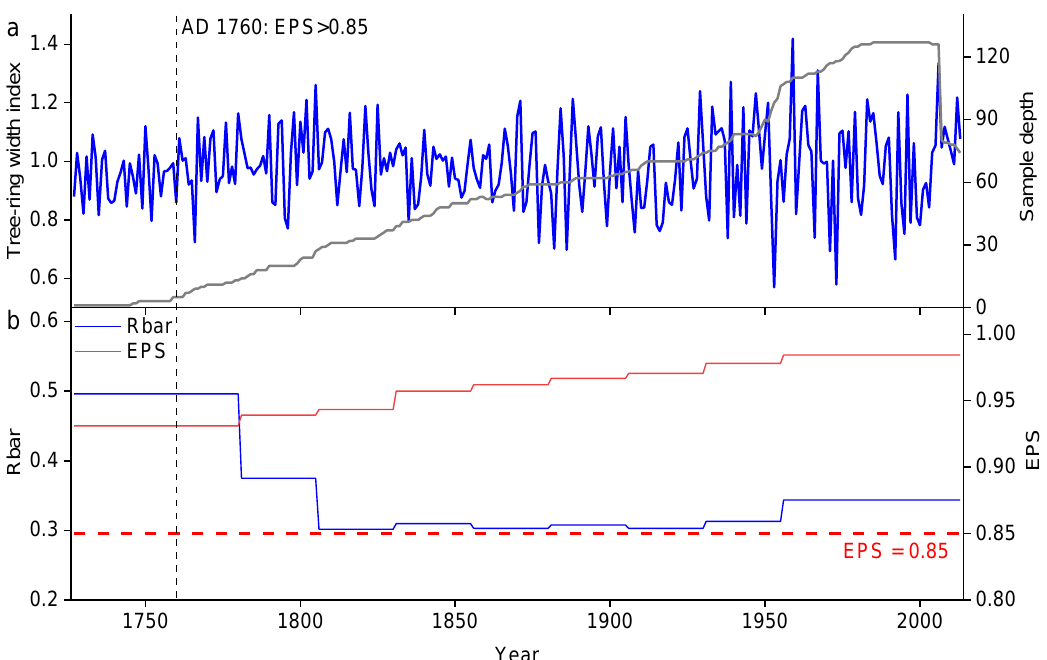
Figure 2. Tree-ring width residual chronology and sample depth from the study site ( a ). Running expressed population signal (EPS) and correlation coefficient (Rbar) statistics. The dashed horizontal line denotes the 0.85 cutoff value ( b ). The reliable chronology begins from the year 1760 (EPS > 0.85).